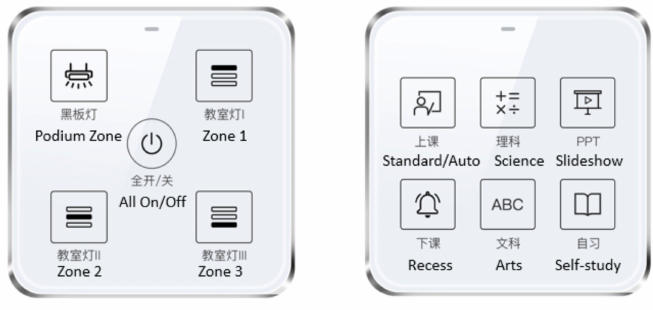
Figure 3. Control panels: Zone switch and scene